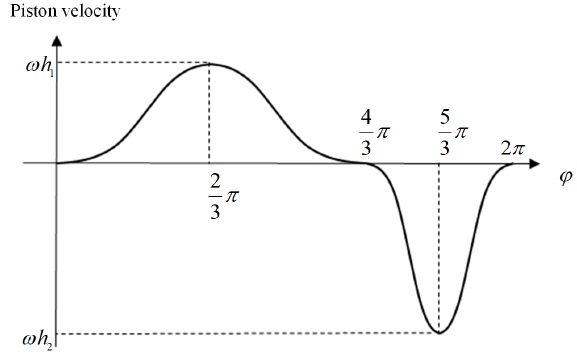
Figure 10. Piston velocity of the three-piston pump using cam